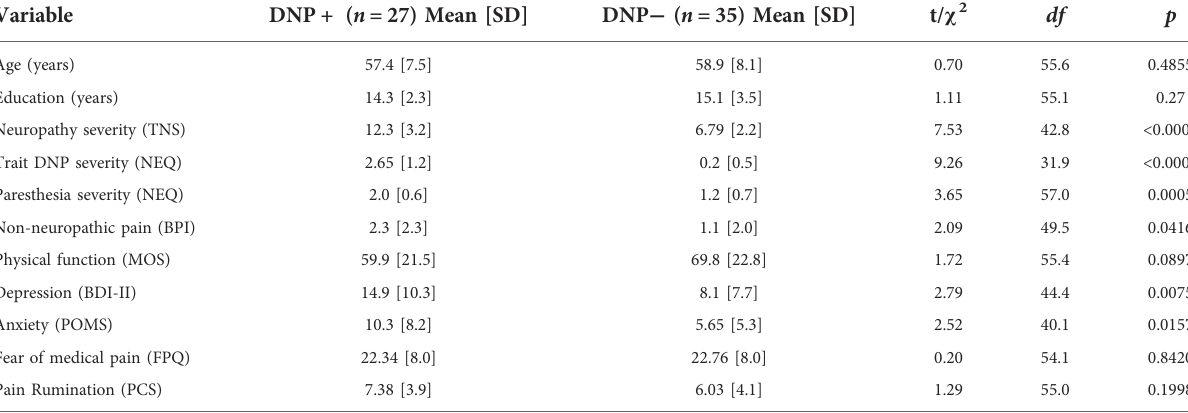
TABLE 1 State distal neuropathic pain (DNP) subgroup demographic and clinical characteristics.